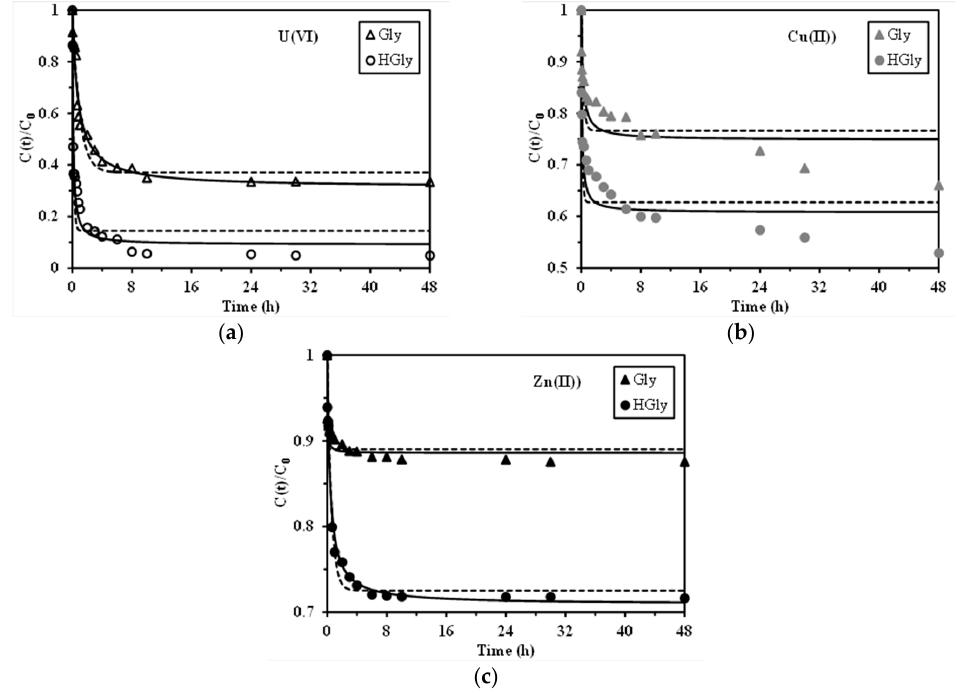
Figure 2. Uptake kinetics for U(VI) ( a ); Cu(II) ( b ); and Zn(II) ( c ) sorption using Gly and HGly sorbents at pH 0 : 5 ( C 0 : 20 mg U L − 1 ; 25 mg Cu L − 1 and 30 mg Zn L − 1 ; SD: 305 mg·L − 1 for Gly/U, 183 mg·L − 1 for HGly/U, 310 mg·L − 1 for Gly/Cu; 200 mg·L − 1 for HGly/Cu; 300 mg·L − 1 for Gly/Zn and 350 mg·L − 1 for HGly/U, 310 mg · L − 1 for Gly/Cu; 200 mg · L − 1 for HGly/Cu; 300 mg · L − 1 for Gly/Zn and 350 mg · L − 1 HGly/Zn; T: 20 °C; v: 150 rpm) (dashed lines: modeling with the PFORE (pseudo-first order rate for HGly/Zn; T: 20 ◦ C; v: 150 rpm) (dashed lines: modeling with the PFORE (pseudo-first order rate equation); solid lines: modeling with the PSORE) (pseudo-second order rate equation). equation); solid lines: modeling with the PSORE) (pseudo-second order rate